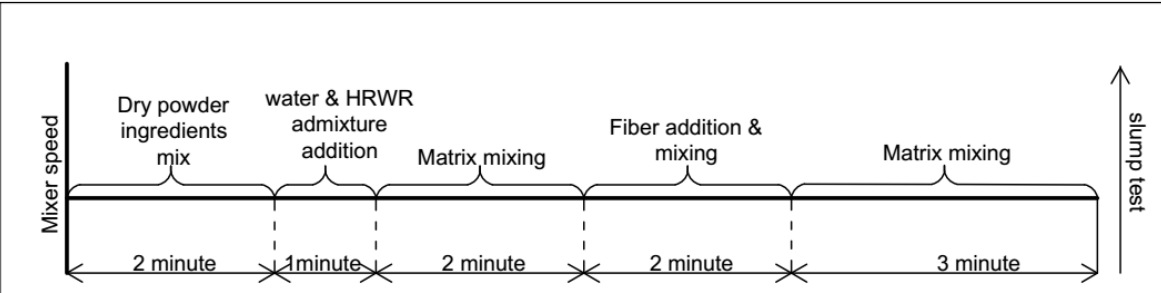
Figure 2. Mixing sequence of procedures applied in this study.